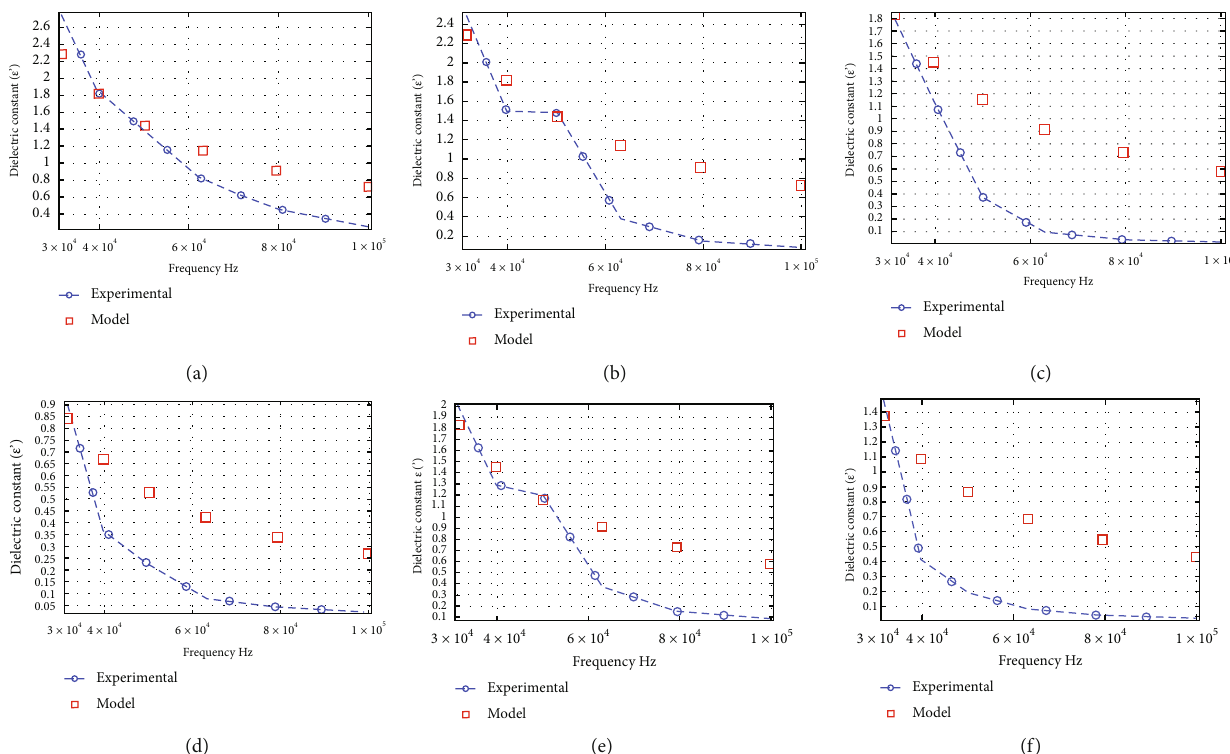
Figure 10: Comparison between the experimental and model results for frequency versus of dielectric constant of (a) olive oil A, (b) olive oil B, (c) Nigella sativa, (d) corn oil, (e) sesame oil, and (f) sun fl ower oil